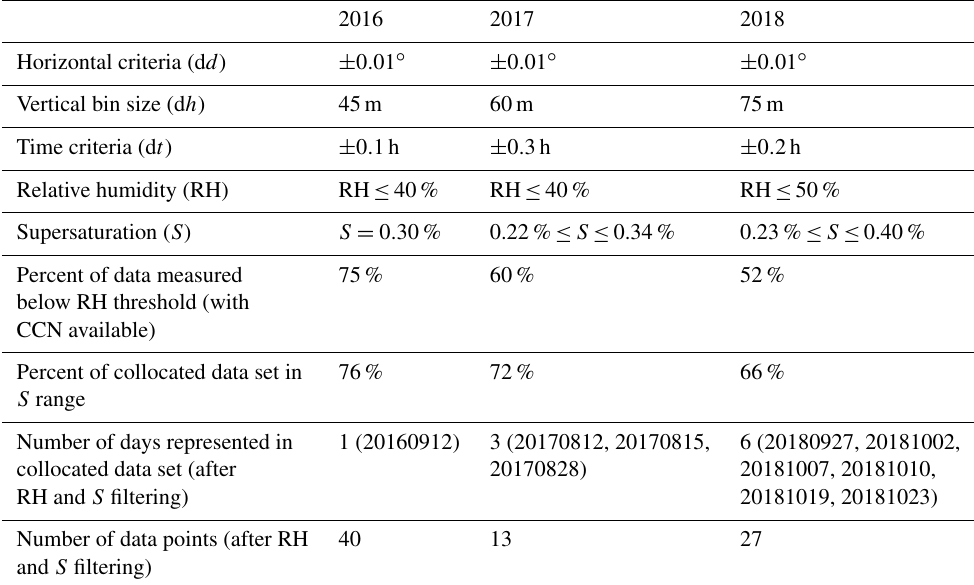
Table 2. Collocation criteria, relative humidity, and supersaturation thresholds chosen to analyze each year of ORACLES. The percentage of the entire data set represented by each relative humidity threshold, percentage of the collocated data set represented by each supersaturation threshold, and final dates and quantity of data points are also